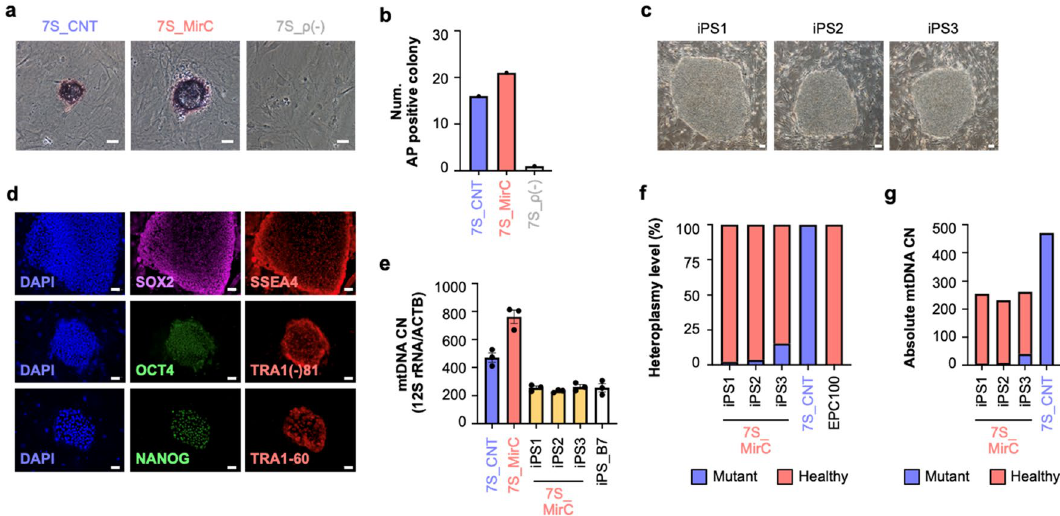
Figure 5. Characterization of induced pluripotent stem cells derived from the MirCs of mitochondrial disease patient fibroblasts. ( a ) Alkaline phosphatase (AP) assay at day 10 following the gene transfer to generate iPS cells showed vulnerable small colonies in 7S fibroblasts (7S_CNT), whereas MirCs (7S_MirC) with healthy mtDNA of 7S fibroblasts demonstrated firm colonies. The ρ(-) cells of 7S fibroblasts (7S_ρ(-)) did not generate any colonies. White bar indicates 50 µm. (n = 1). ( b ) The numbers of AP-positive colonies were not very different from those of the original cells and MirCs. ( c ) Representative photographs of iPS colonies in the long term. White bar indicates 100 µm. ( d ) Expression of stem cell markers, such as SOX2, OCT3/4, NANOG, SSEA4, TRA1-81, and TRA1-60. White bar indicates 50 µm. ( e ) MtDNA CNs in iPS cells derived from MirCs of 7S fibroblasts. (n = 3, respectively). ( f ) Heteroplasmy in three lines of iPS cells maintained the original rate of MirCs (n = 1). ( g ) The absolute CNs of healthy and mutated mtDNAs were calculated. CN: copy